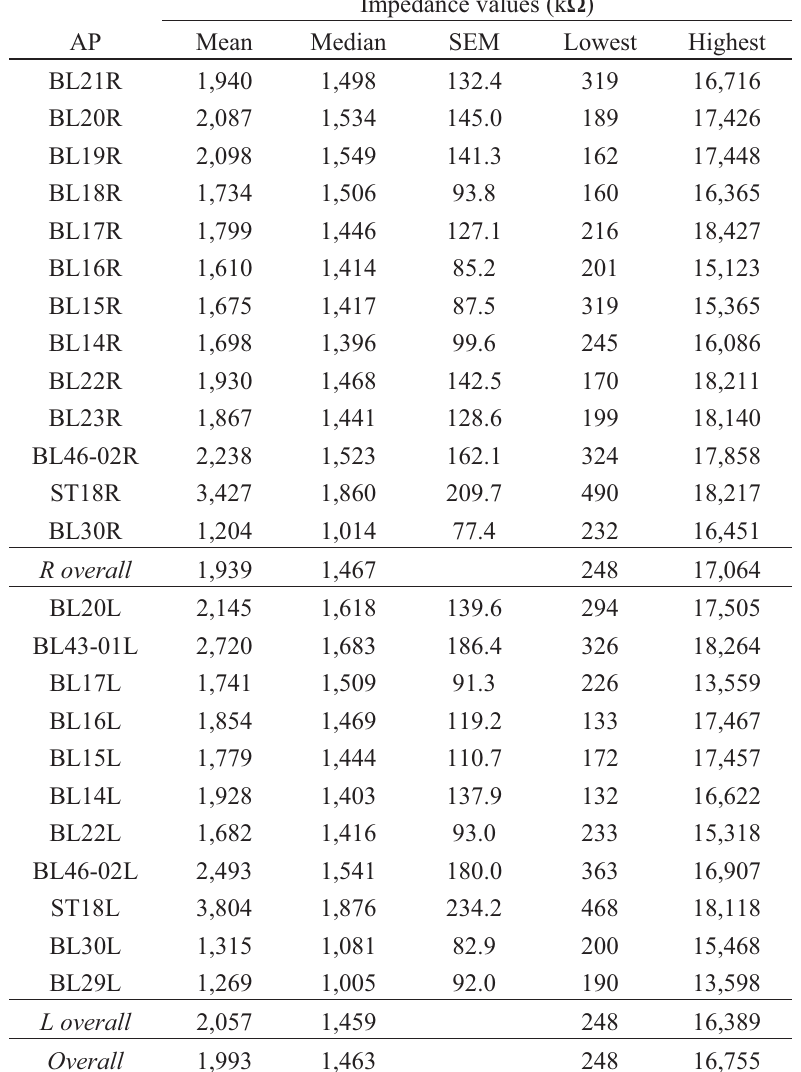
Table 4. Mean, median, SEMs, highest and lowest impedance values in Experiment 2. Impedance values